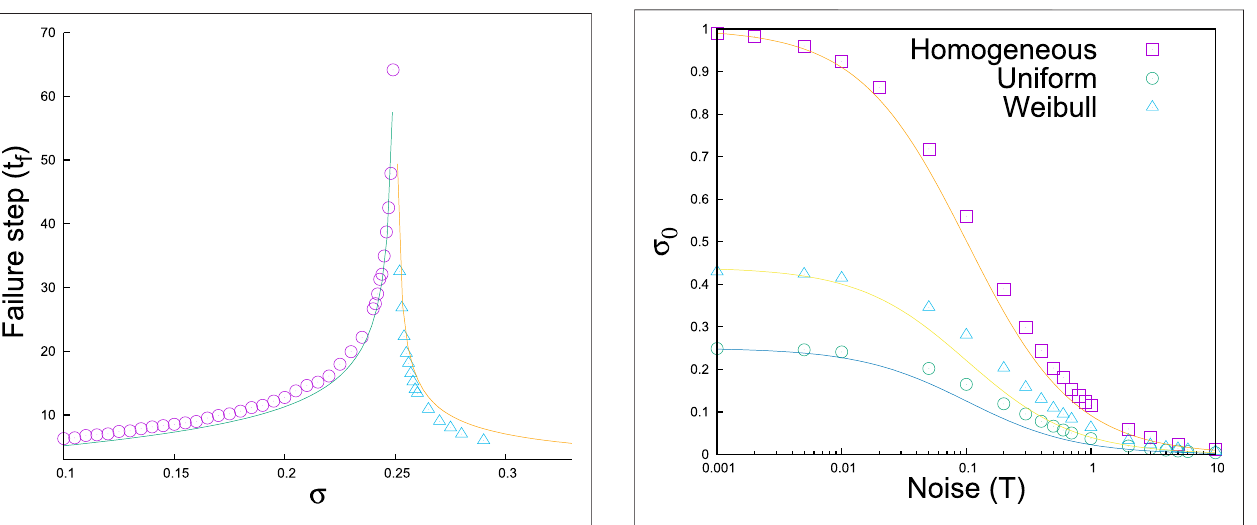
FIGURE 5 | Postcritical and precritical relaxation: Numerical data are for a bundle with N (cid:1) 10 6 fi bers having uniform threshold distribution and averages are taken over 10 5 samples. Lines are showing theoretical estimates.